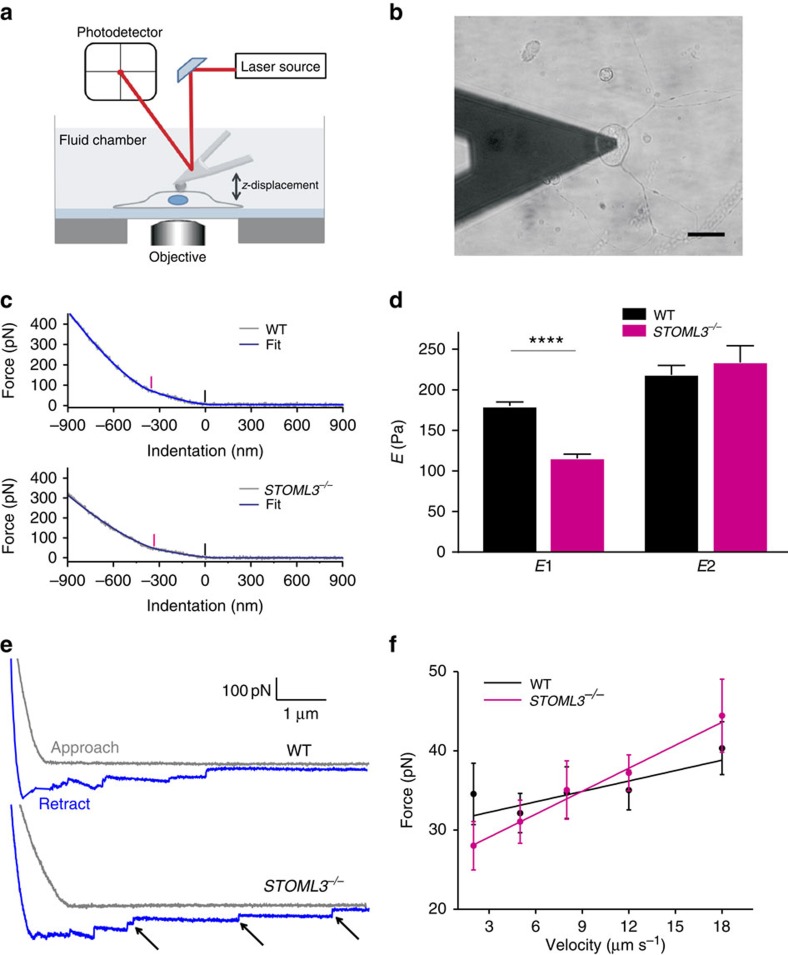
Altered membrane mechanical properties in STOML3-deficient sensory neurons.(a) Sketch of AFM set-up used for indentation measurements including a bead (4.5 μm diameter) glued at the end of a tipless cantilever. The cantilever is moved up and down by a piezo system. The bending of the cantilever is measured by a laser beam detected by a photodetector. And the AFM cantilever bending is linearly proportional to the force applied on the cell. (b) Differential interference-contrast optical image of the bead cantilever pushed onto a cultured DRG neuron (scale bar, 20 μm). (c) Examples of force–indentation curves for WT and STOML3−/− sensory neurons as fitted for double contributions: in the curve two regimes with different elastic properties can be identified (black marker, first point for first elastic component E1, and pink marker second point for second elastic component E2) (Methods, Supplementary Figs 2 and 3). (d) Quantitative comparison of elasticity modulus E1 and E2 values obtained by the fitting procedure (WT: n=110 neurons from 4 cultures, 4 animals; STOML3−/−: n=120 neurons from 4 cultures, 4 animals; two-way ANOVA with post hoc Bonferroni's test, P<0.05). See also Supplementary Fig. 4. (e) Representative force–distance curves (approach in grey, retraction in blue) acquired at 5 μm s−1. On the retraction curve, after first detachment force several step-like structures are clearly discernible (indicated by arrows), corresponding to the sequential detachment of membrane tethers from the cantilever. (f) Tether force as a function of pulling velocity in WT and STOML3−/− sensory neurons (WT: n=20 neurons from 2 cultures, 2 animals; STOML3−/−: n=19 neurons from 2 cultures, 2 animals). Solid lines are the linear fit of force–velocity curves used to estimate the static tether force at zero F0 and the effective viscosity ηeff (Methods, Supplementary Table 2) (R-value is 0.6 for WT and 0.97 for STOML3−/−). ****P<0.0001; Error bars indicate s.e.m.